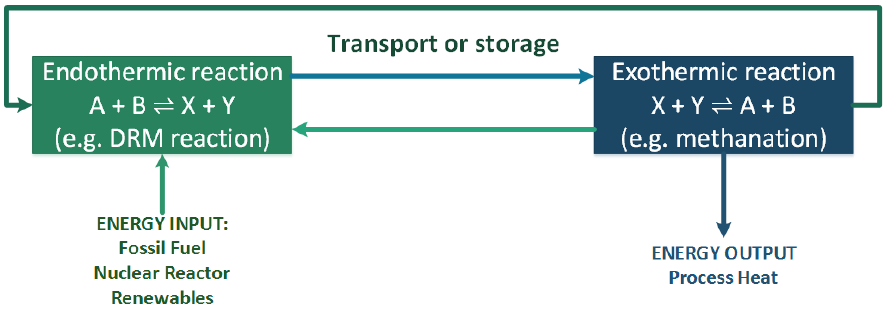
Figure 1. Chemical energy storage concept, using heat from renewables or nuclear and dry reforming of methane (DRM) and methanation as energy carriers.